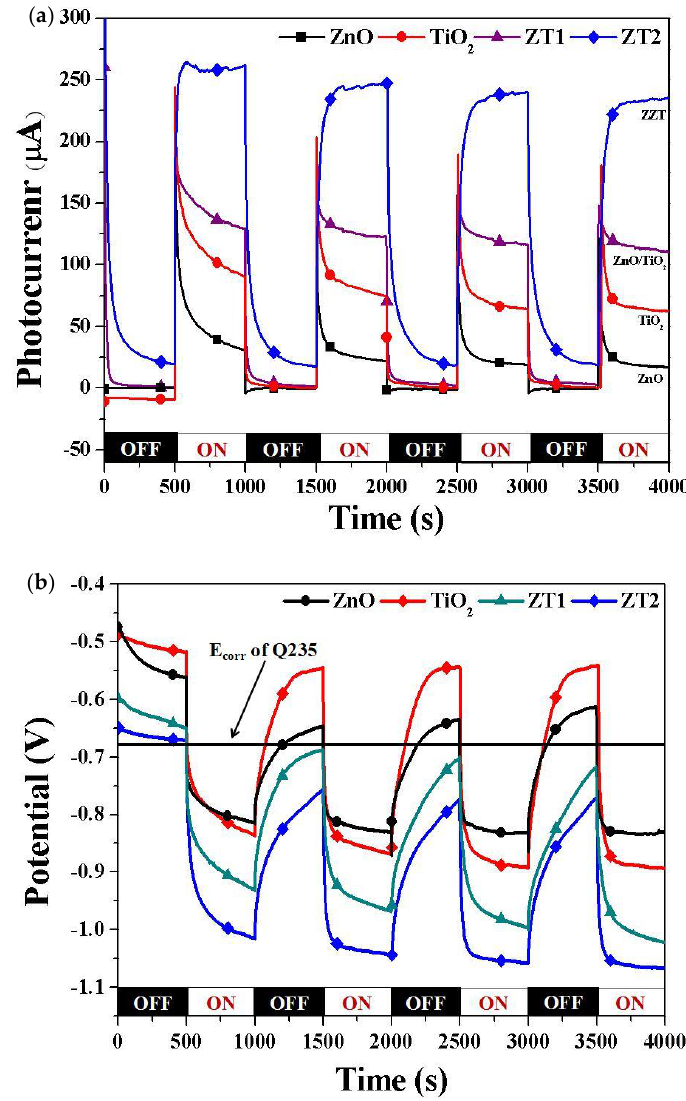
Figure 8. ( a ) Photocurrent density and ( b ) OCP of Q235 electrode coupled with different films under intermittent simulated sunlight in 3.5 wt% NaCl solution.